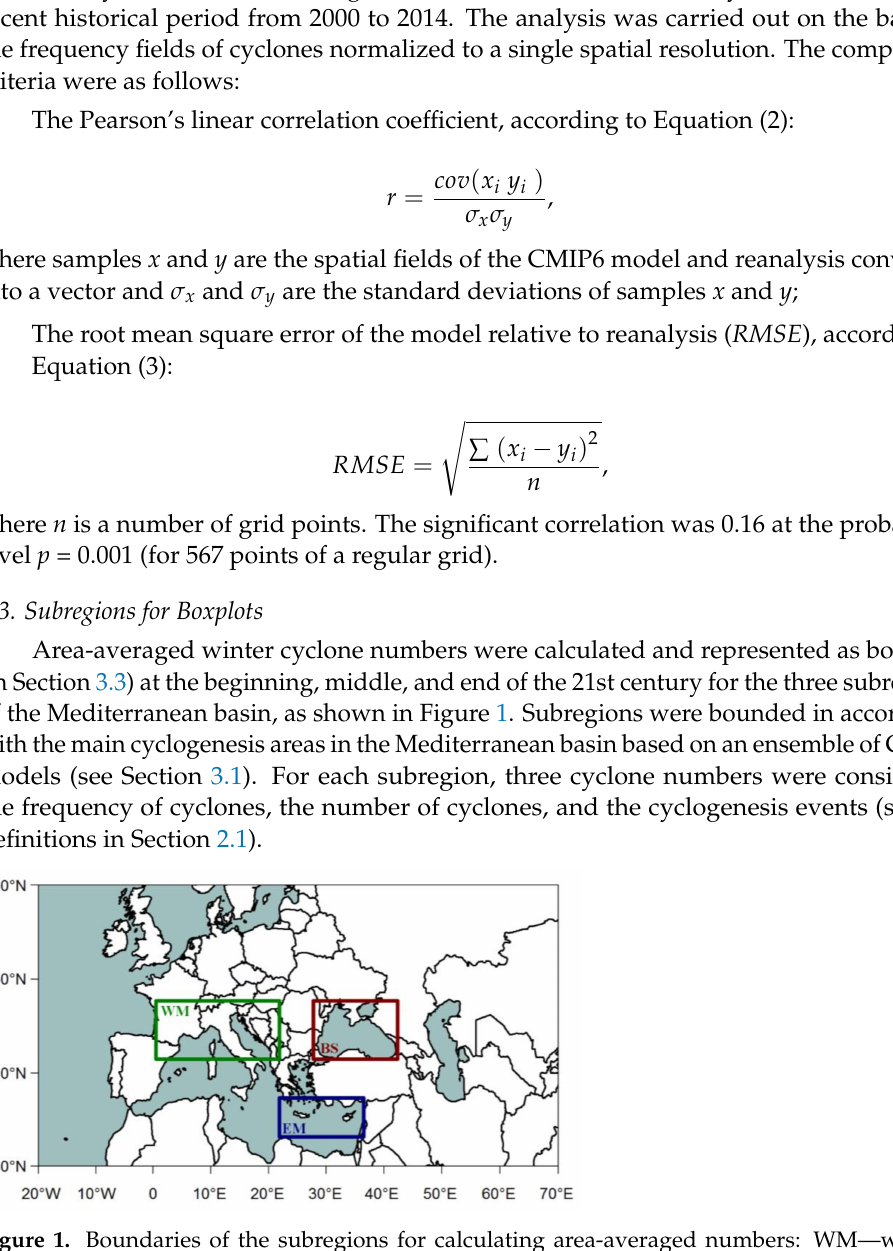
Figure 1. Boundaries of the subregions for calculating area-averaged numbers: WM—western Mediterranean (green rectangle, 1 ◦ W to 21 ◦ E, 41 ◦ N to 47 ◦ N); EM—eastern Mediterranean (blue rectangle, 21 ◦ W to 36 ◦ E, 33 ◦ N to 37 ◦ N); and BS—Black Sea (red rectangle, 27 ◦ W to 42 ◦ E, 41 ◦ N to 47 ◦